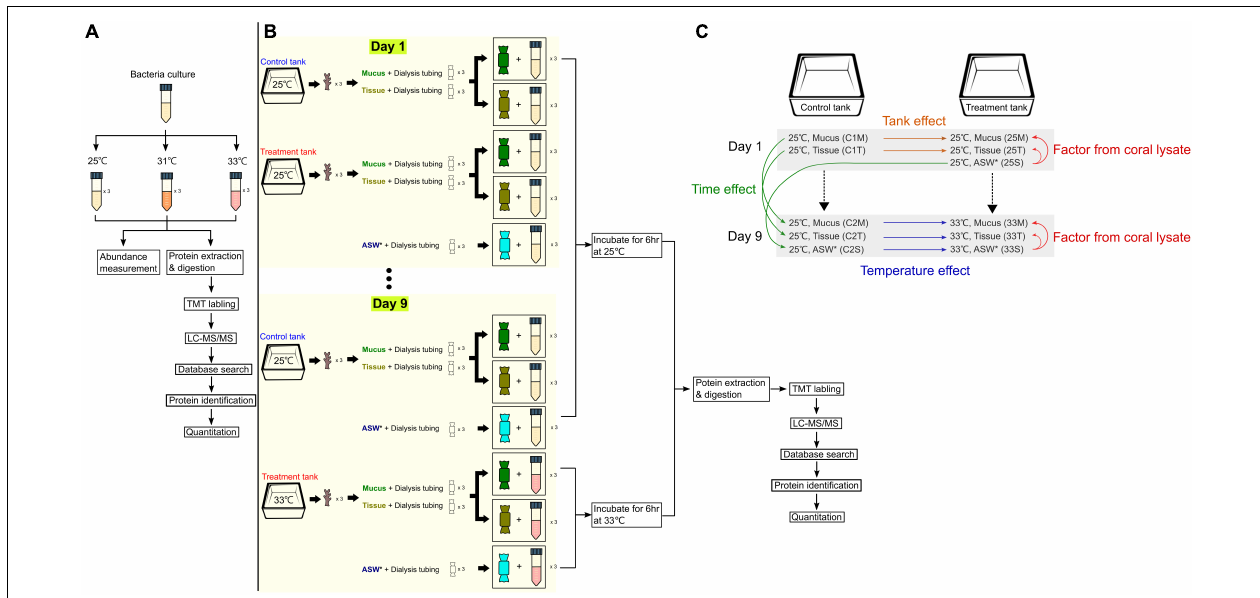
FIGURE 1 | Experimental designs and setup. (A) Experiment to identify differentially expressed proteins when the bacterial culture ( Endozoicomonas montiporae CL-33 T ) was exposed to different heat stresses. (B) Setup for coral lysate experiment, where coral mucus and tissue were incubated with cultures of E. montiporae CL-33 T for 9 days, with temperature increased by 1 ◦ C per day (25 to 33 ◦ C). (C) Overview of the different factors analyzed throughout the coral lysate experiment. * denotes artificial sea